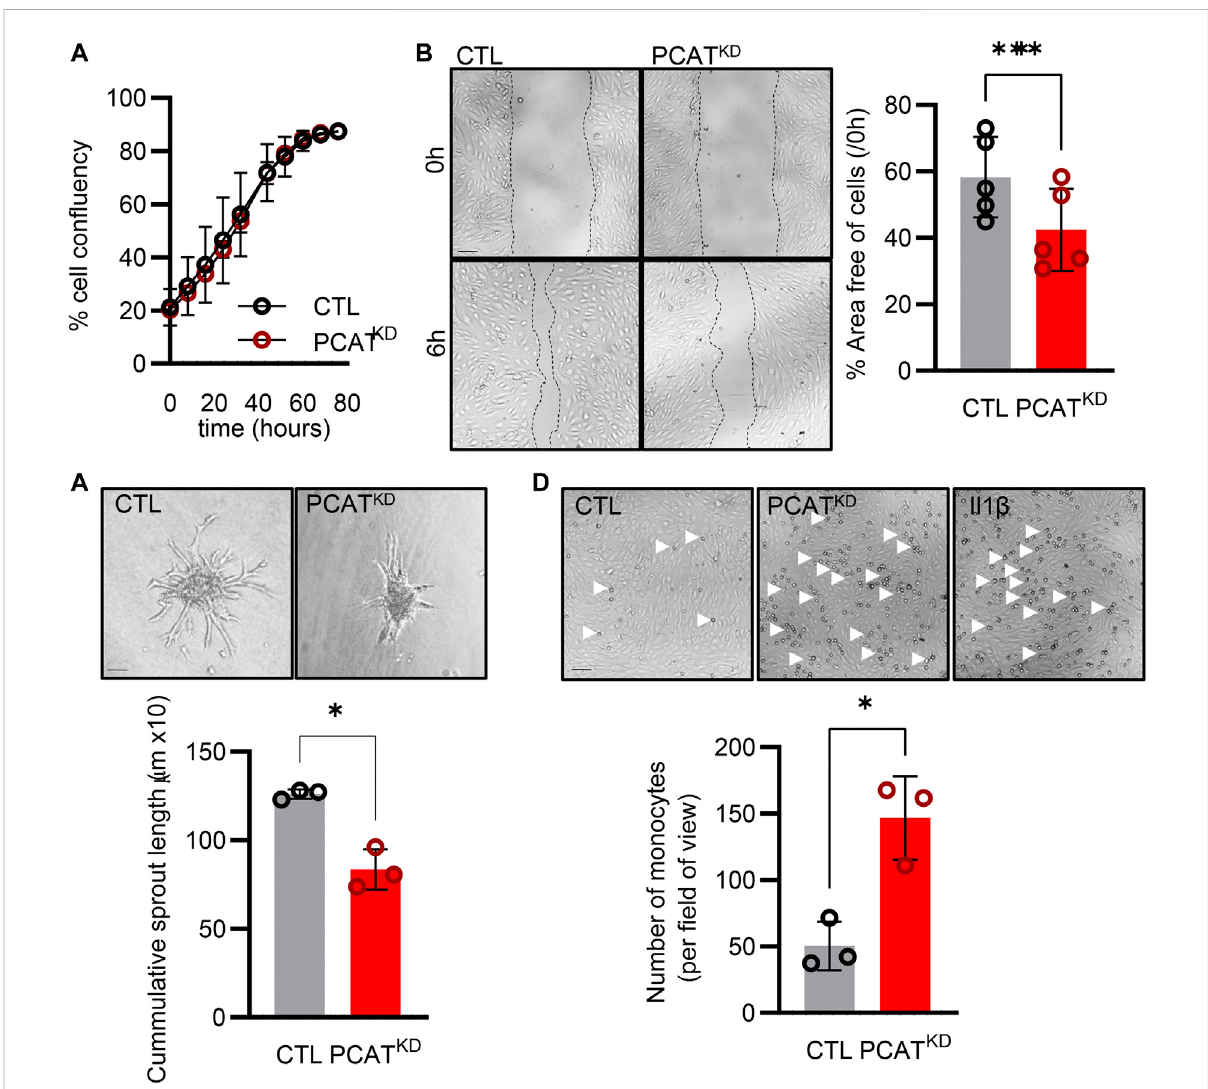
FIGURE 3 EffectofPCAT14deletiononendothelialangiogenicresponsesandactivation.Humanumbilicalveinendothelialcells(HUVEC,Passage3)were transfectedwith a GapmeR (50 nmol/L, 72 h) targeting PCAT14 (PCAT KD )or a respective control (CTL). (A) Percentage of endothelial cell con fl uence for up to 48 h. (B) Representative bright fi eld images and quanti fi cation following a wound scratch assay at 0 and 6 hours. (C) Representative bright fi eldimagesandquanti fi cationofendothelialcellsproutsona3Dspheroidassay. (D) Representativebright fi eldimagesandquanti fi cation of THP-1 monocytes adhered to endothelial cells. As a positive control, endothelial cells treated with Interleukin 1 β (Il-1 β , 10 ng/mL, 4 h). n =3-6 biological replicates per group, experiments performed at least 2 times. Scale bar = 500 μ m, * p < 0.05, ** p < 0.01, Student ’ s t-test paired, N.S: Not Signi fi cant;